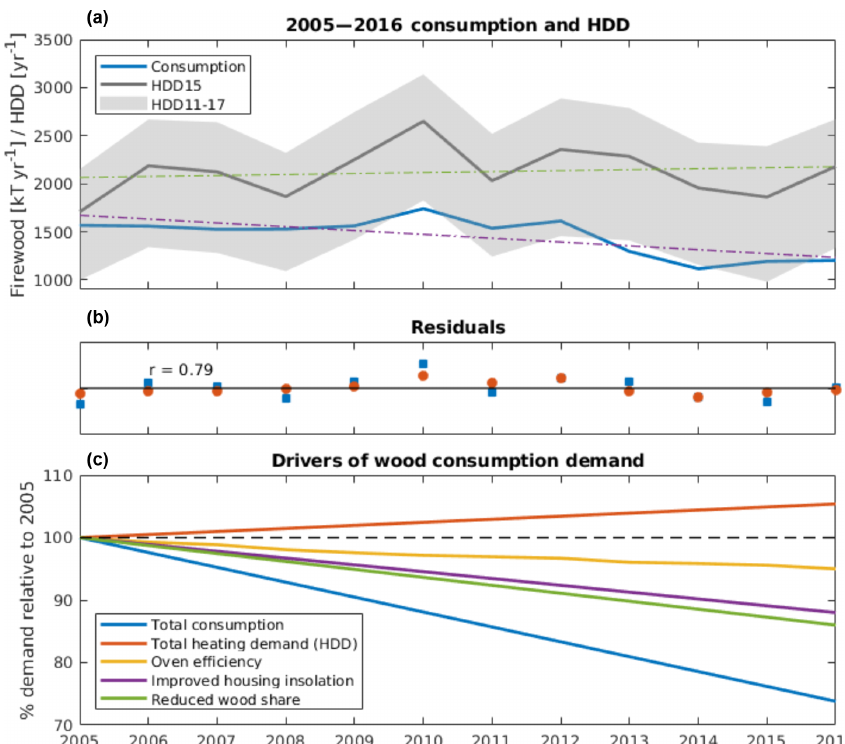
Figure 5. (a) The HDD in the simulation domains in Fig. 3 weighted by the population in each domain along with the annually reported consumption 2005–2016. The dashed line is the linear trend. (b) Normalised residuals to linear trends 2005–2016. (c) The blue line show the linear trend in consumption. Explanatory variables for this change (2005–2016) are changes in heating demand (HDD; in red), the efficiency of wood ovens (assumed 75% for new, 50% for old and 15% for open; in yellow), the reduced energy required to heat buildings due to improved insulation (purple), and the decreasing share of total domestic energy consumption that comes from wood